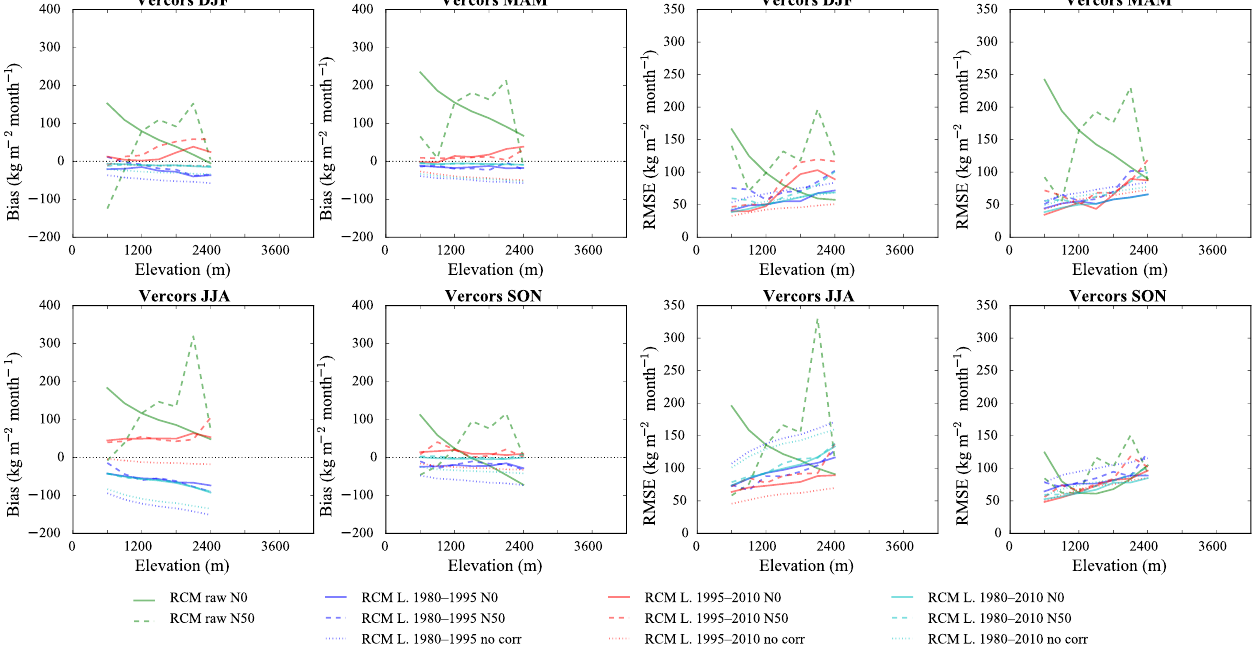
Figure 6. Precipitation mean bias and root mean square error (RMSE) of each raw and adjusted RCM simulation compared to the SAFRAN reanalysis over the evaluation period for the Vercors massif as a function of